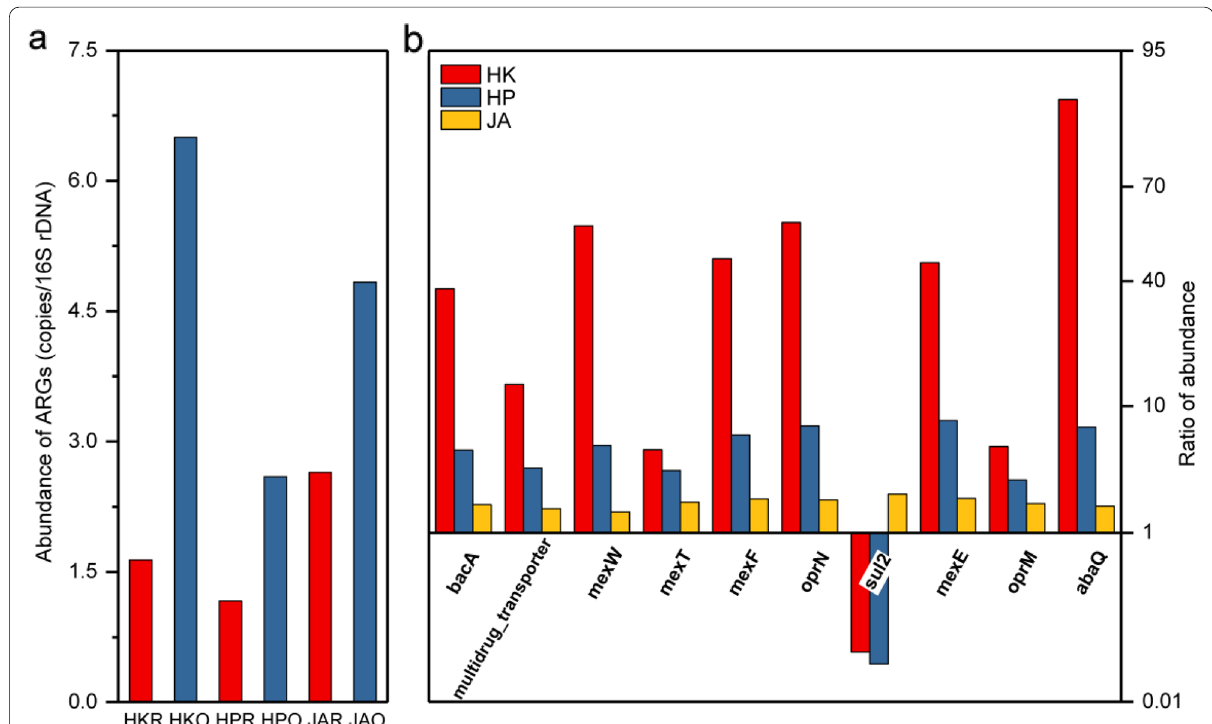
Fig. 7 Release characteristics of airborne ARGs. (a) Abundance (copies/16S rDNA) of ARGs at six sampling sites (waste reception halls of three transfer stations: HKR, HPR, JAR; top vents of three transfer stations: HKO, KPO, JAO). (b) The abundance ratio of the top vent to waste reception hall for the ten ARG subtypes with the highest average abundance